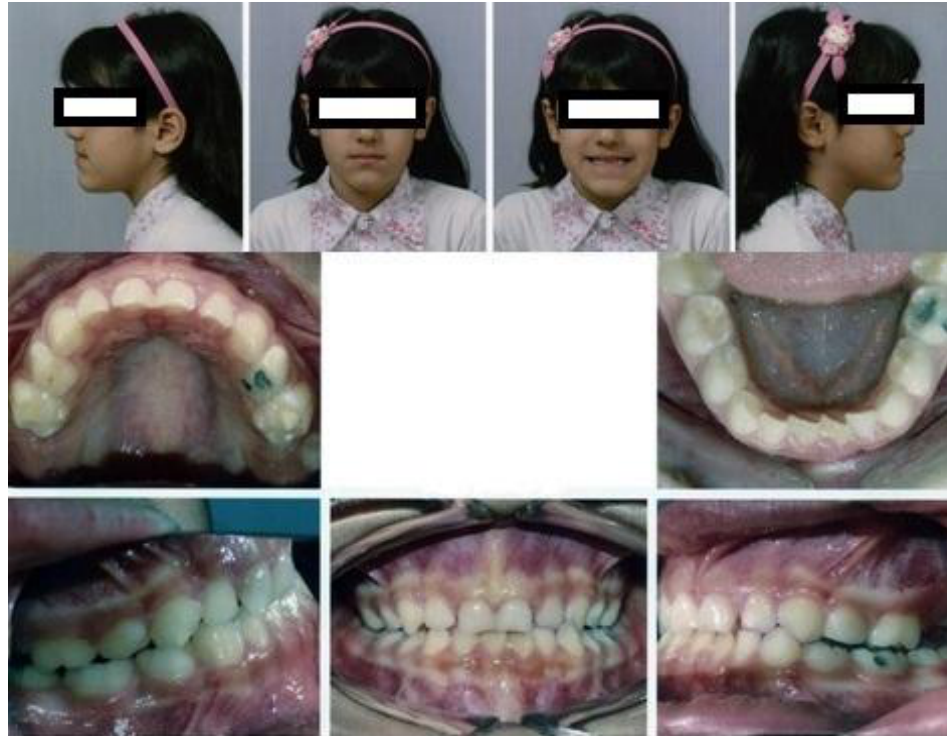
Figure 1. Intra-oral and extra-oral views of the upper and lower dental